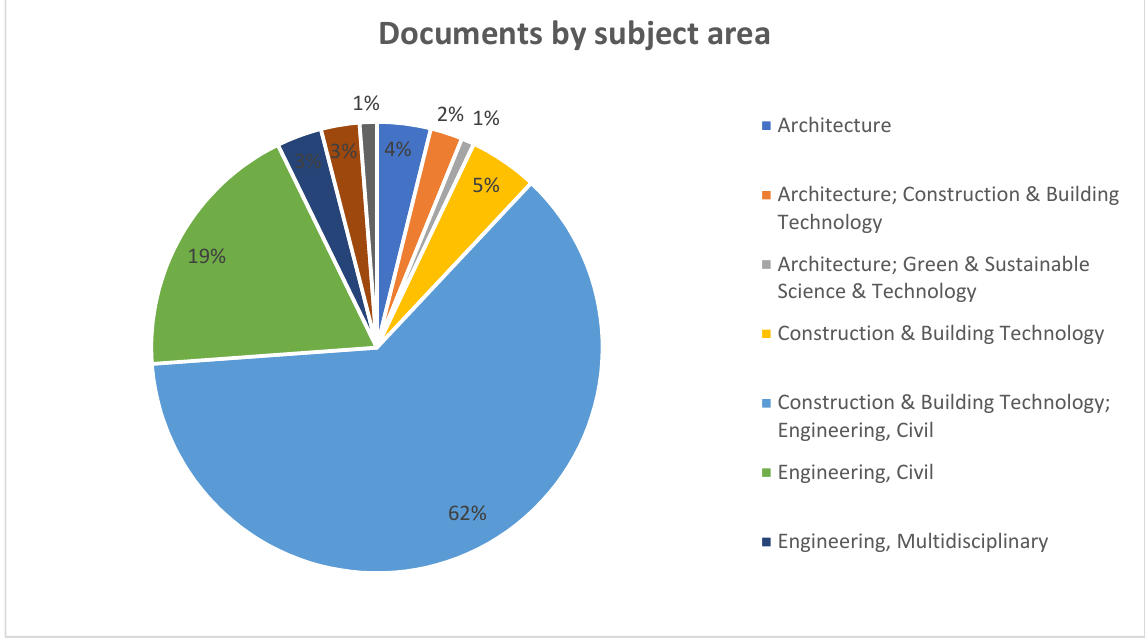
Figure 2. Documents by subject area.